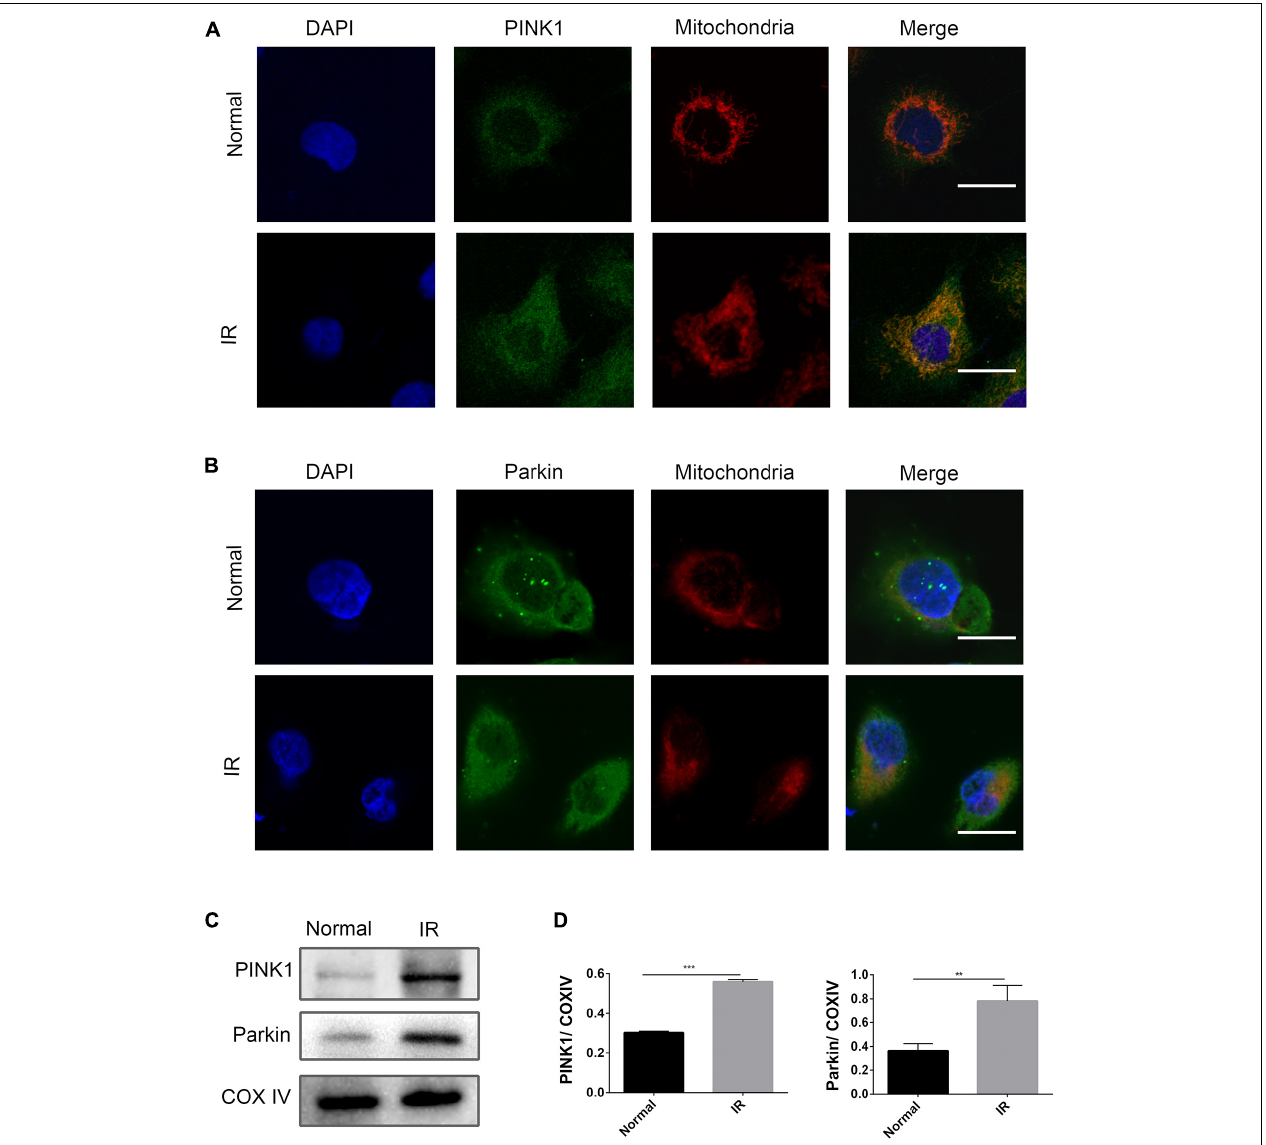
FIGURE 2 | PINK1/Parkin pathway was activated by ischemia–reperfusion (I/R) in HK-2 cells. ( A , B ) Representative images of immunofluorescence double-labeling PINK1/Parkin and translocase of outer mitochondrial membrane 20 (TOMM20). TOMM20 was used as a mitochondrial tracker. PINK1 or Parkin was labeled by fluorescein isothiocyanate (FITC) (green), TOMM20 was labeled by tetramethylrhodamine isothiocyanate (TRITC) (red). Strong colocalization signals in I/R group were seen as yellow dots after merging, suggesting that PINK1 or Parkin gathered on the mitochondria. Scale bar = 50 µ m. (C,D) Immunoblot analysis and quantification of PINK1 and Parkin. Data represent means ± SD. n = 3. ** p < 0.01, *** p <